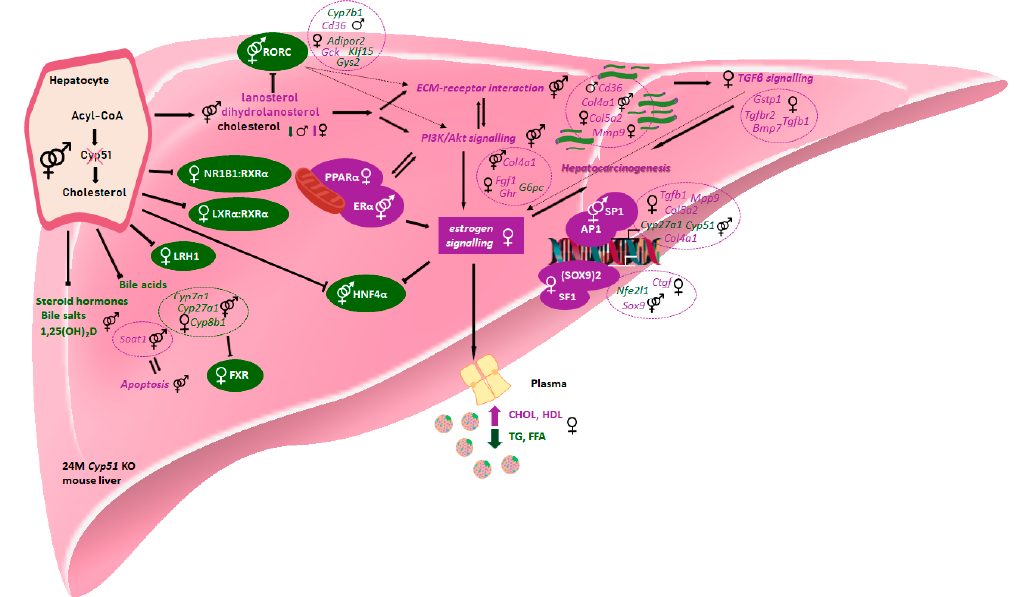
Figure 6. Sex-dependent metabolic and transcriptional changes after disrupted Cyp51 from cholesterol synthesis align with hepatocarcinogenesis in humans. Arrows indicate active connections between enriched genes, KEGG pathways, and TFs. Blocked arrows represent repression. Hatched arrows represent possible transcription regulation of the selected pathway or connection between selected pathways in KO mice. Metabolites, DE genes, KEGG pathways, and TFs are violet if positively enriched and green if negatively enriched. Icons were used from the Reactome icon library. All selected mouse signalling and metabolic pathways and TFs were aligned with human literature data.